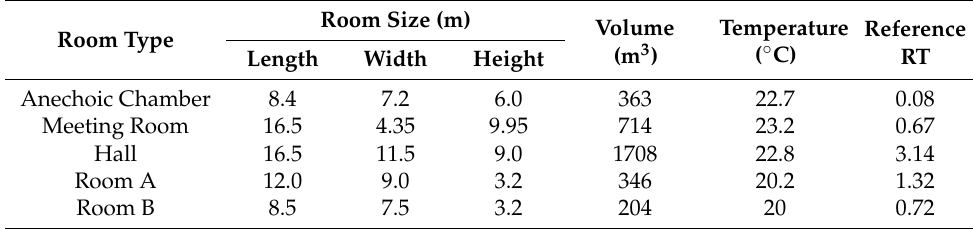
Table 1. Information of the measured